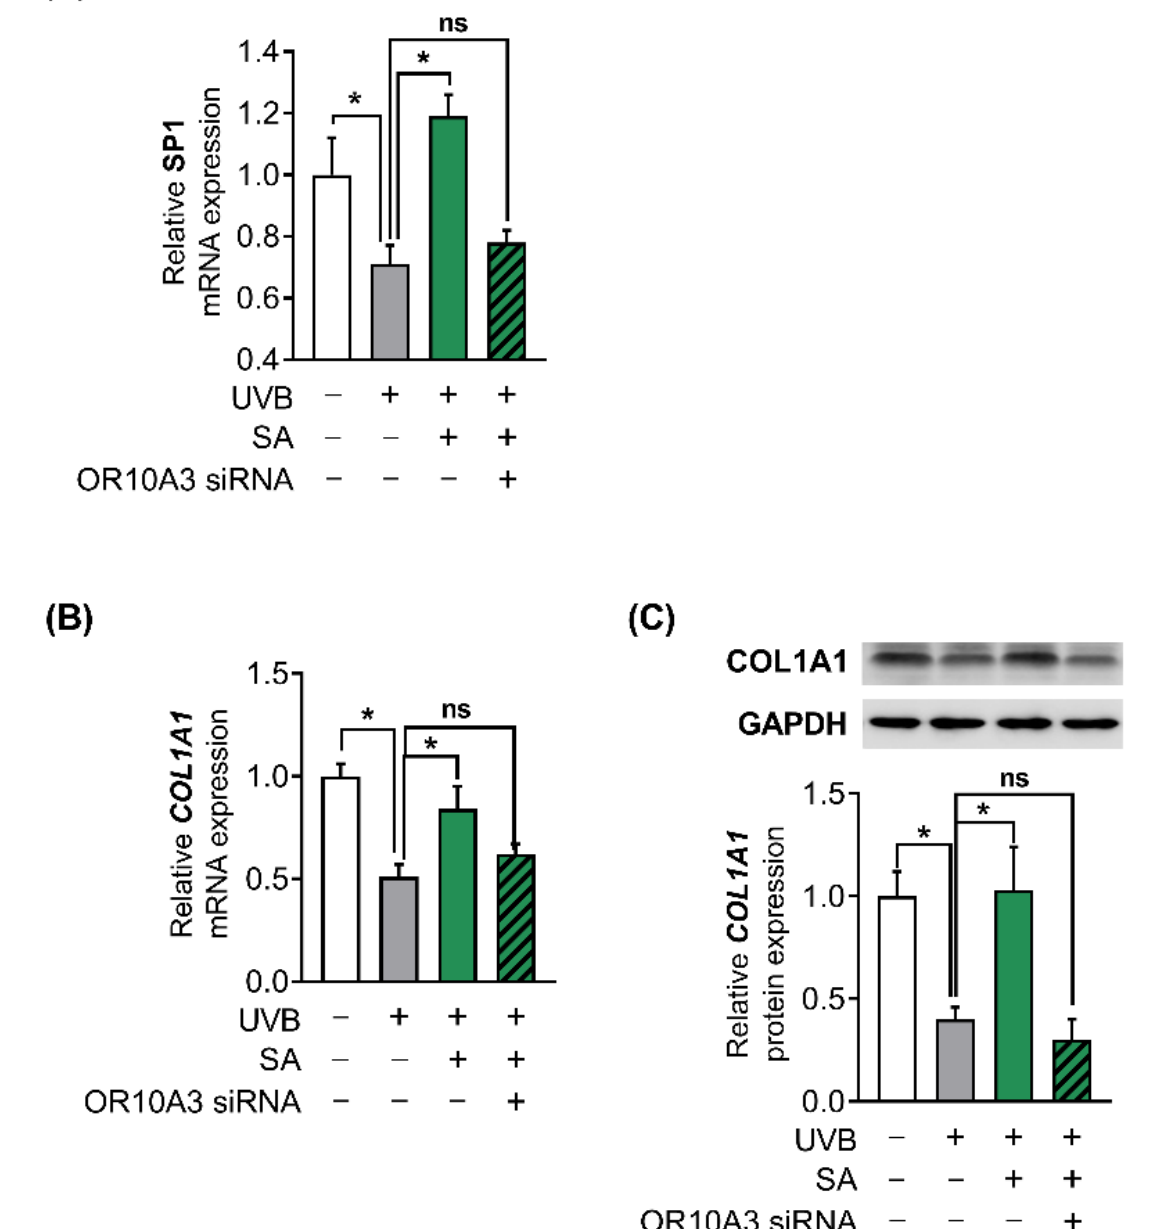
Figure 7. The activation of OR10A3 by suberic acid enhanced gene expression of Akt downstream transcription factor and its target gene COL1A1 in UVB-exposed Hs68 cells. The cells were treated with suberic acid (SA; 100 uM) or the vehicle after being exposed to UVB. The OR10A3 siRNA or NT siRNA was pretreated for 1 h before the suberic acid treatment. ( A ) The mRNA expression of SP1 was analyzed. ( B , C ) The mRNA and the protein expression of COL1A1 were analyzed. GAPDH was used as an internal control. Data are presented as mean ± SEM of three independent experiments. Statistically significant differences are marked as * p < 0.05; ns, not significant.